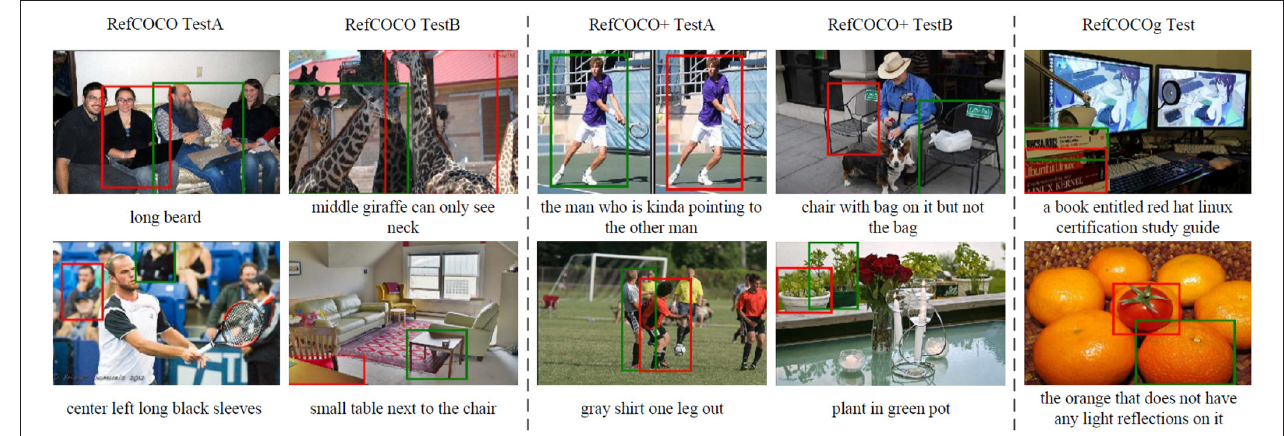
FIGURE 4 | Examples of incorrect predictions. The red boxes show wrong visual groundings, and the green boxes denote the ground truth bounding boxes.